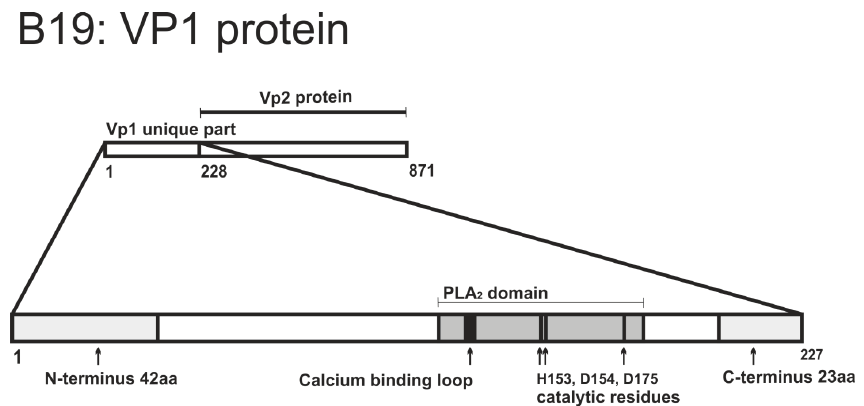
Figure 3. Overview of sequence features of B19 VP1 unique